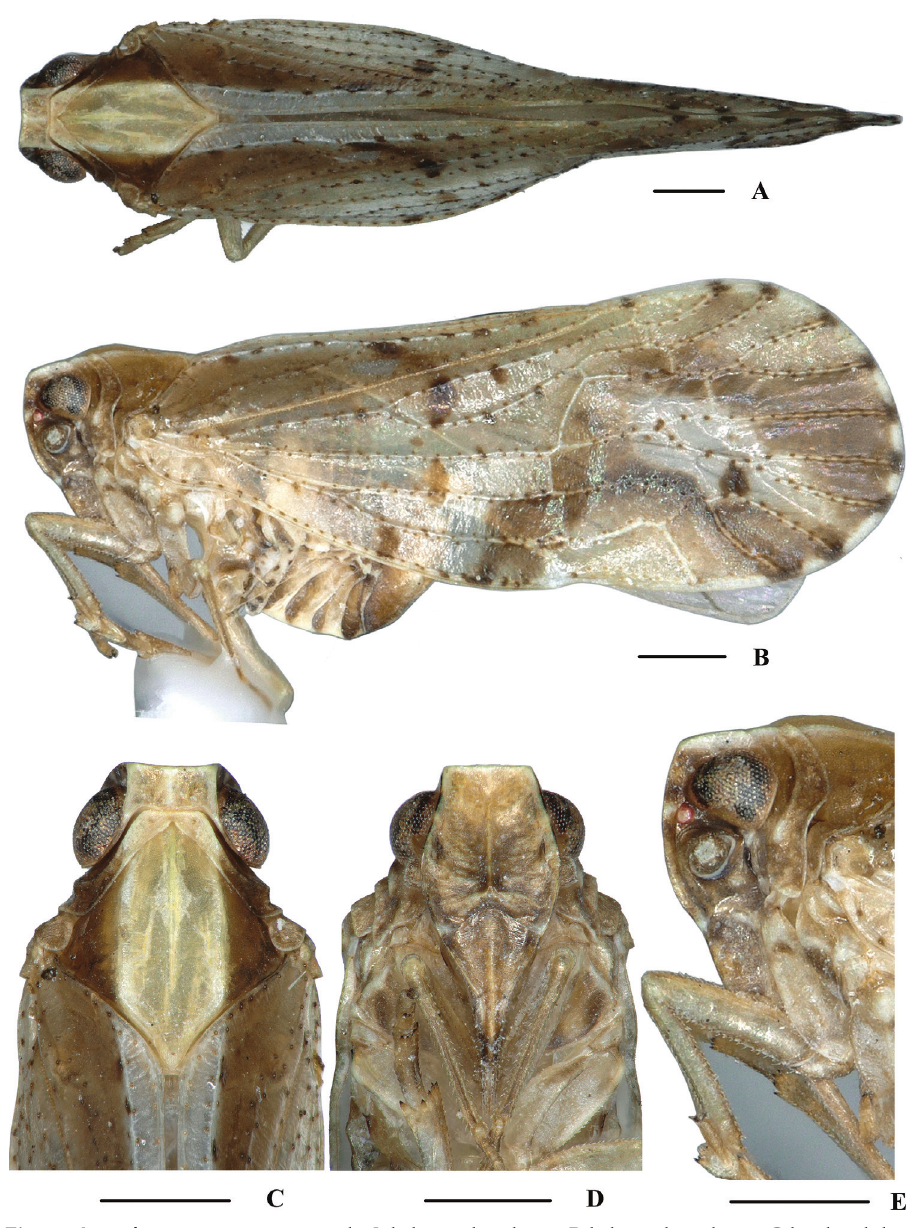
Figure 1. Kirbyana aspina sp. nov., male A habitus, dorsal view B habitus, lateral view C head and tho- rax, dorsal view D face, ventral view E head, lateral view. Scale bars: 0.5